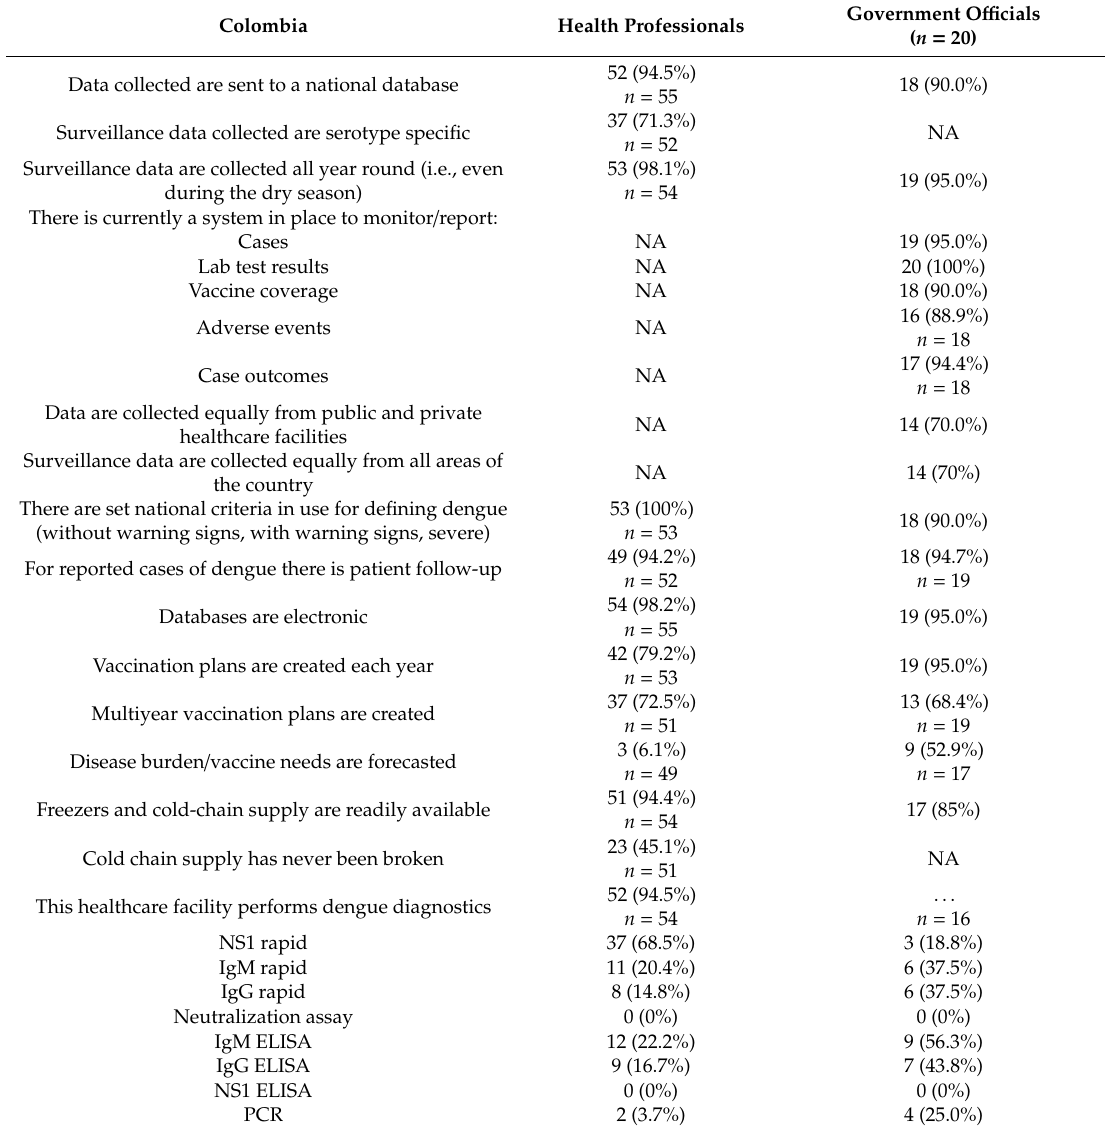
Table 2. Logistical preparedness. Percentage of respondents who answered “yes” to the following statements regarding surveillance data collection, current vaccination programs, and dengue diagnostics routinely used at their institutions. NA—not applicable (the question was not posed to this survey